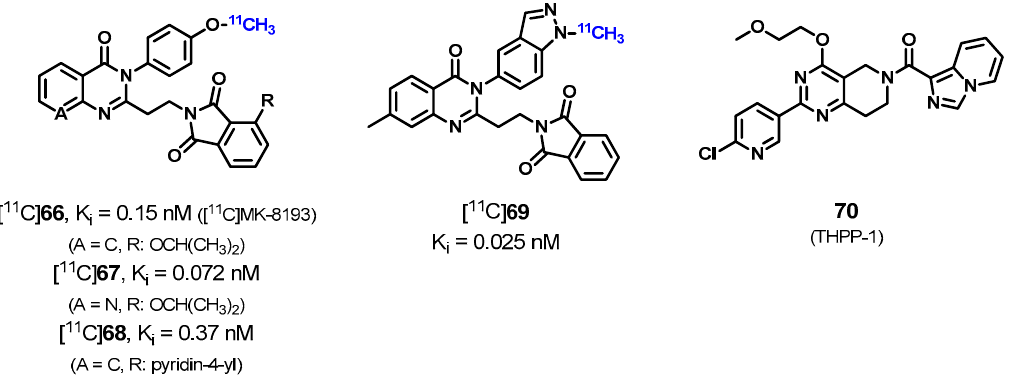
Figure 14. Molecular structures of 11 C-labeled PDE10A radioligands for PET and the PDE10A inhibitor 70 .